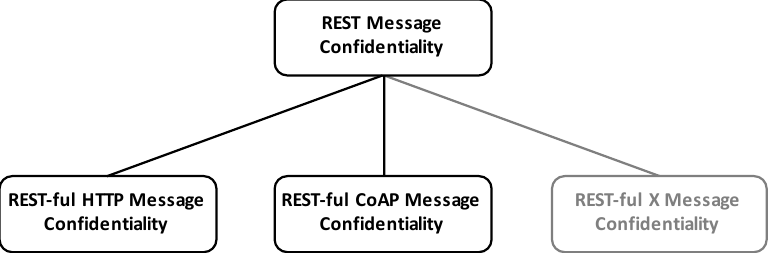
Figure 10. General REST message confidentiality and its instantiation to concrete REST-ful